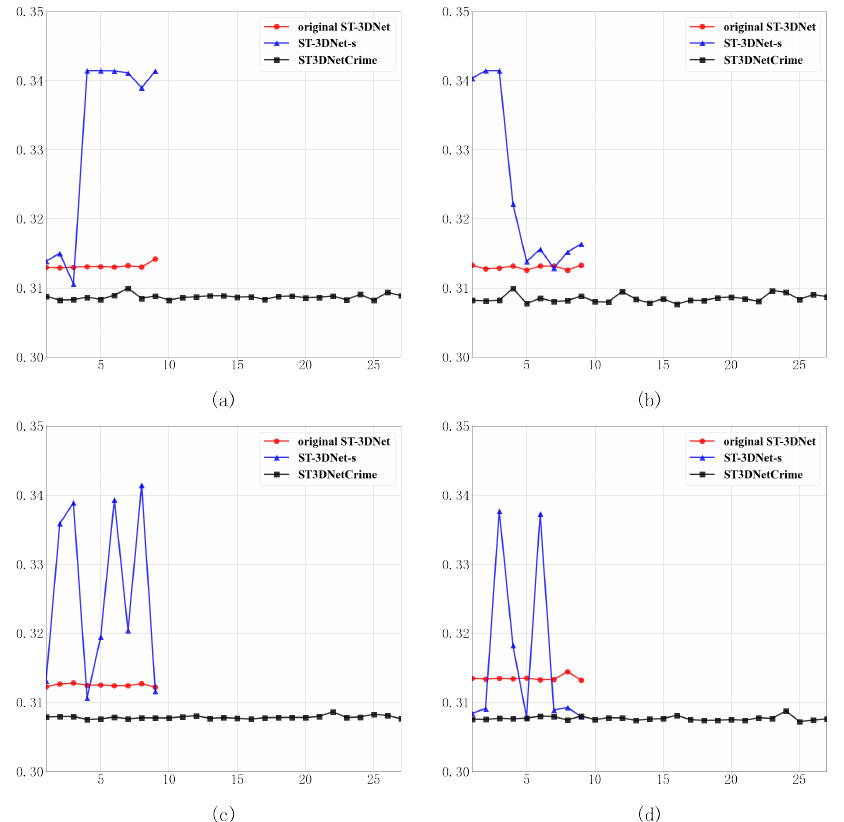
Figure 8. RMSE comparison under different values of l c , l p and l q in four randomly selected com- binations of the number of filters in the convolution layers ( N filters ) and the number of residual units ( N res ): ( a ) N filters = 64, N res = 6; ( b ) N filters = 32, N res = 6; ( c ) N filters = 16, N res = 2; ( d ) N filters = 8, N res = 2. Units: x -axis: number of combinations of the independent sequence lengths; y -axis: RMSE